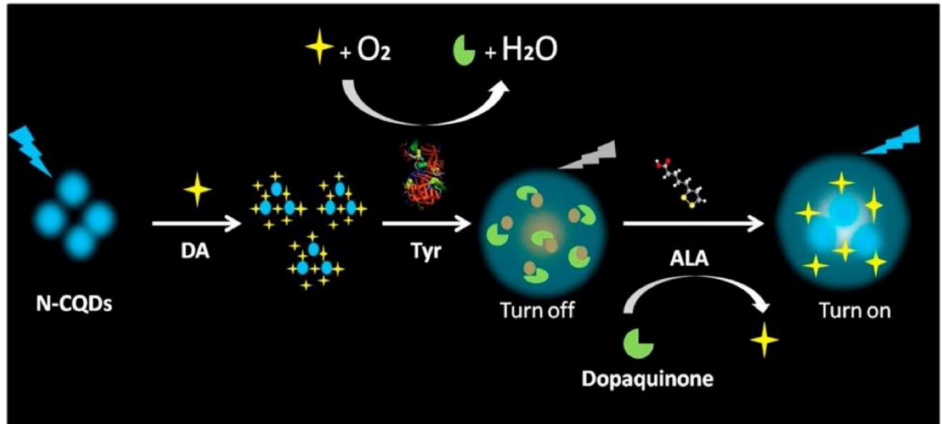
Figure 12. Underlying principle for the sensing of dopamine and alpha lipoic acid. Reprinted from ref. [147], with permission from